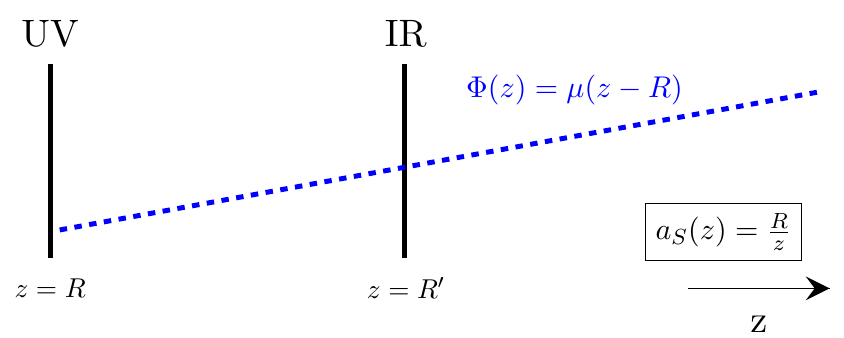
Figure 5 . A sketch of our geometry in the string frame. The IR brane carries local (cid:12)elds that result in jump conditions for the bulk